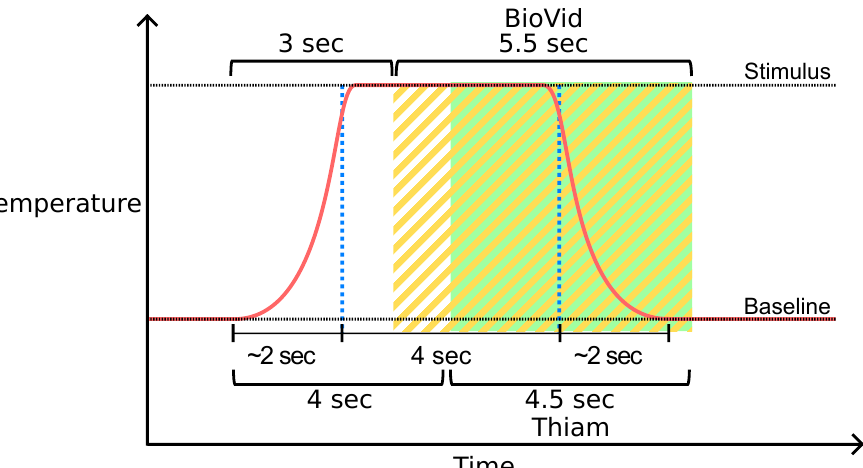
Figure 4. Window segmentation of the BioVid Heat Pain Database (BVDB) dataset. Window seg- ments available in the public BVDB are highlighted in yellow. Thiam et al. [38] proposed another segmentation process highlighted in green that is used in [30,33] as